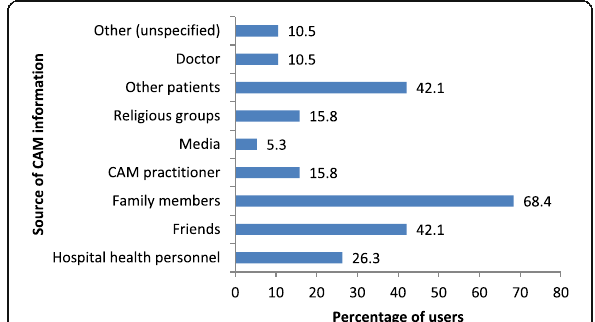
Fig. 4 Source of information about CAM. CAM, complementary and alternative